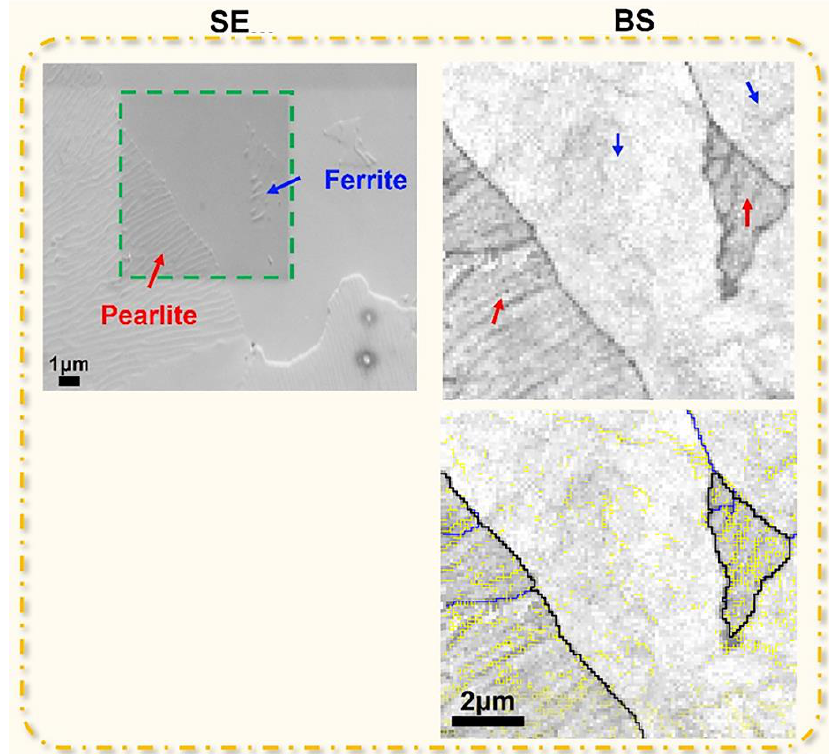
Figure 5. SE and BS maps showing the microstructure within the gauge length section of the sample. Fatigued at 600 MPa for 8900 cycles. The EBSD mapping is taken from the area shown by the green dashed square area in the SE map. The blue arrows show the ferrite region, while the red arrows show pearlite areas. The two BS maps are identical. Only different coloring schemes are used. The top picture uses the band slope coloring, whereas, in the lower one, black lines show dislocation boundaries with misorientation angles of θ > 15°, yellow lines show dislocation boundaries with misorientation angles in the range of 0.7° < θ < 2° and blue lines show dislocation boundaries with misorientation angles of 2° < θ < 15°.